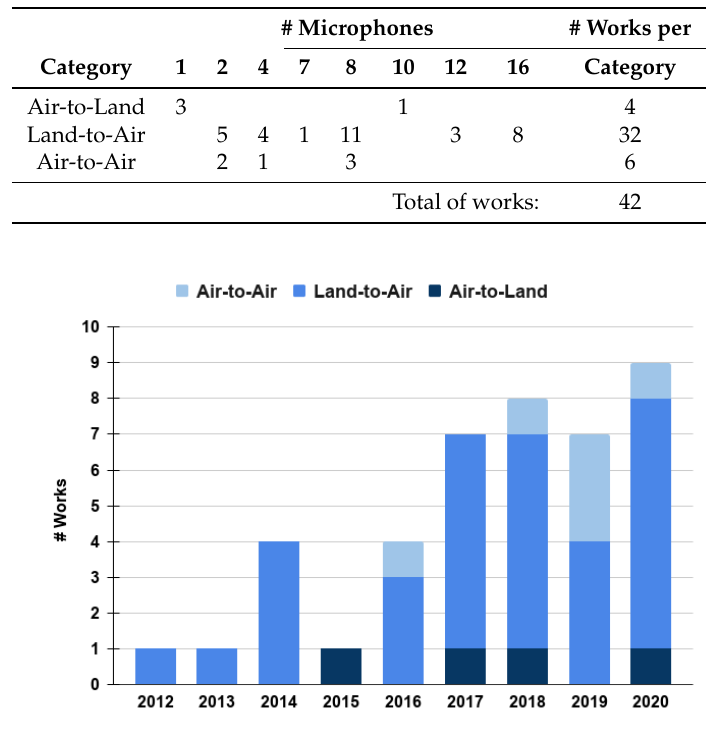
Figure 5. Distribution of works over the years according to the categories of auditory perception as defined in this review: air to land, land to air and air to air. Note that the category with the least number of works is air to land; we have identified that these works are usually related to the detection objective. Air to air also has a few works that have been reported in the last five years